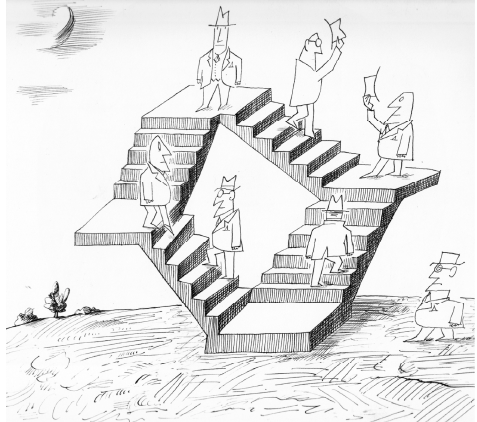
Figure 6. S. Steinberg, from The Discovery of America ,